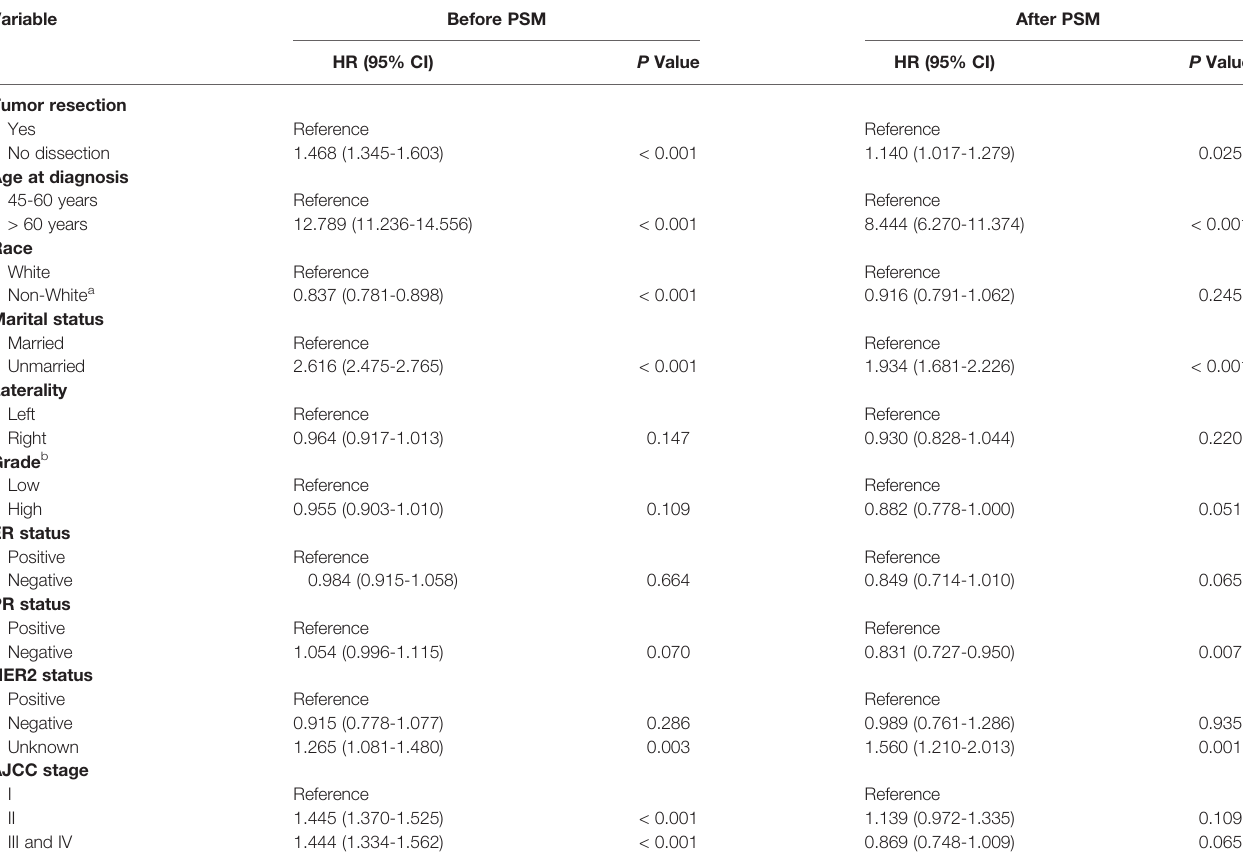
TABLE 2 | Univariate competing-risks regression analysis of cardiovascular death.